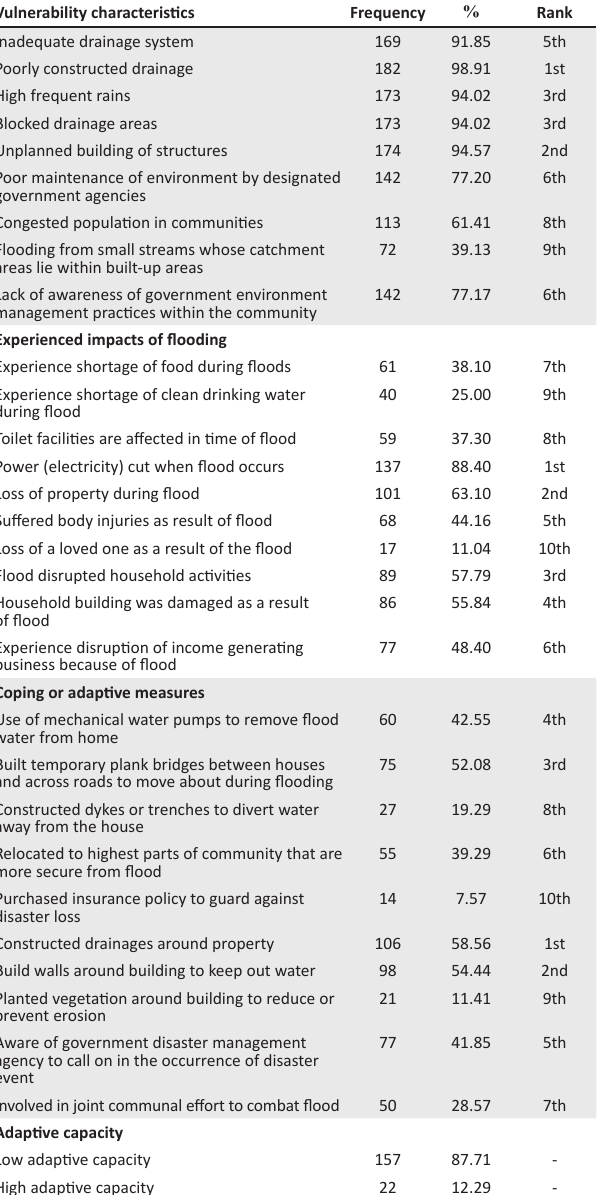
TABLE 5: Assessment of urban households’ vulnerability and disaster preparedness.